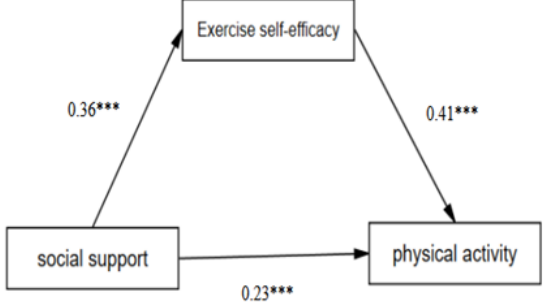
Figure 1. The mediating e ff ect of exercise self-e ffi cacy. (Notes: *** means p > 0.001.)